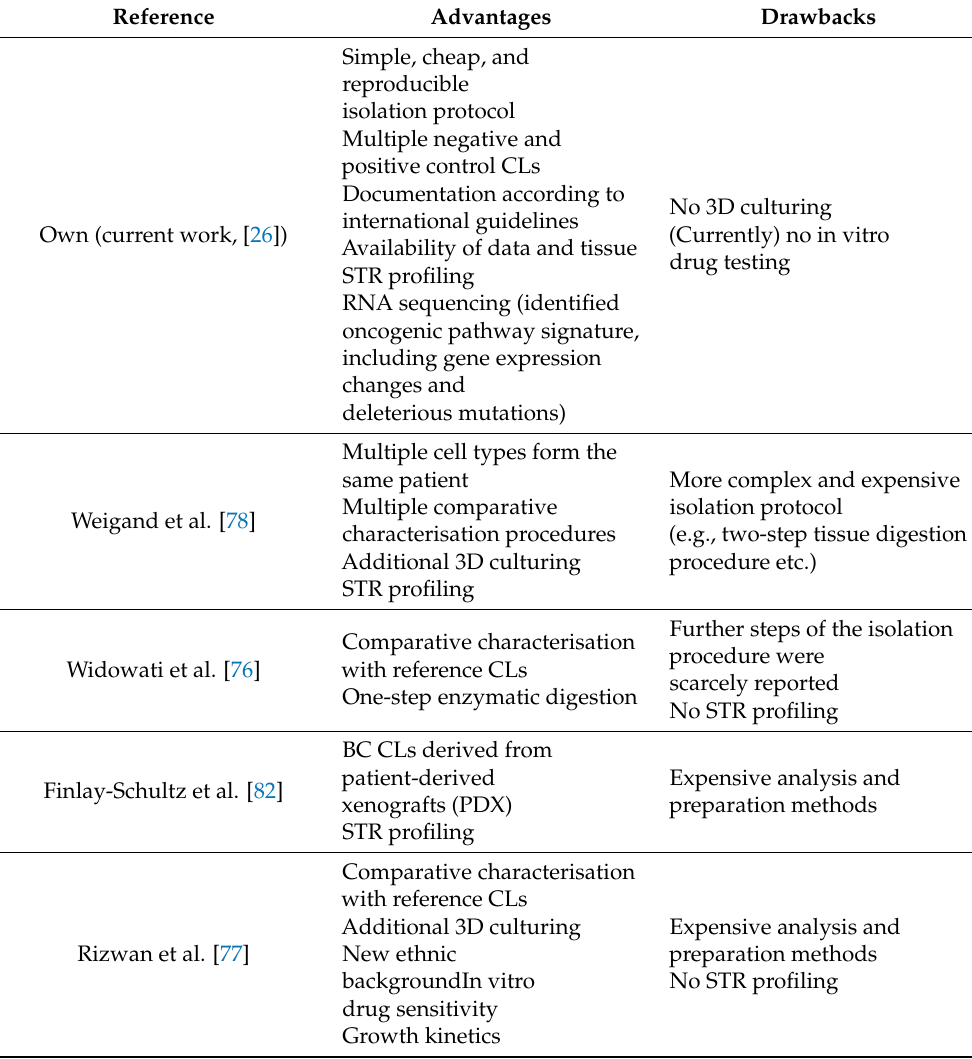
Table 3. Comparison of different isolation and characterisation